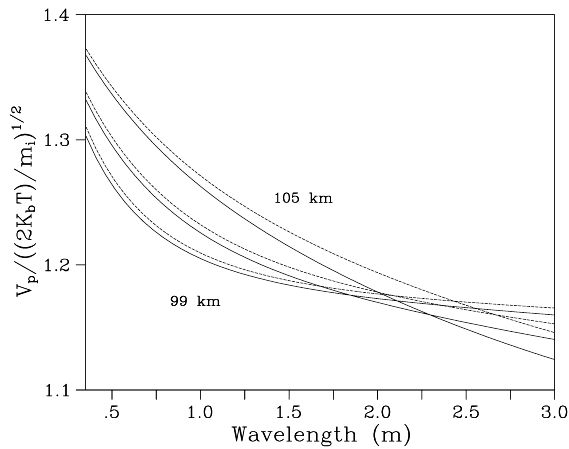
Fig. 8. Ratio of the phase speeds of marginally unstable Farley Buneman waves to the isothermal ion acoustic speed as a function of wavelength, calculated at 99, 102, and 105km altitude. Solid and dashed lines show results for T e = T i =190K and 215K,